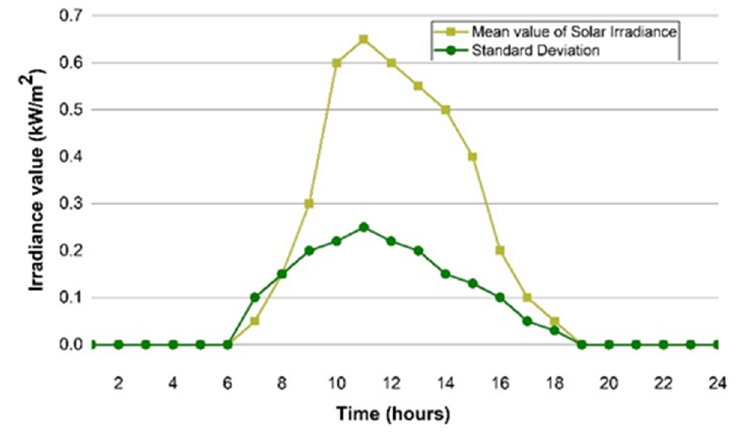
Figure 3. Standard deviation and mean value